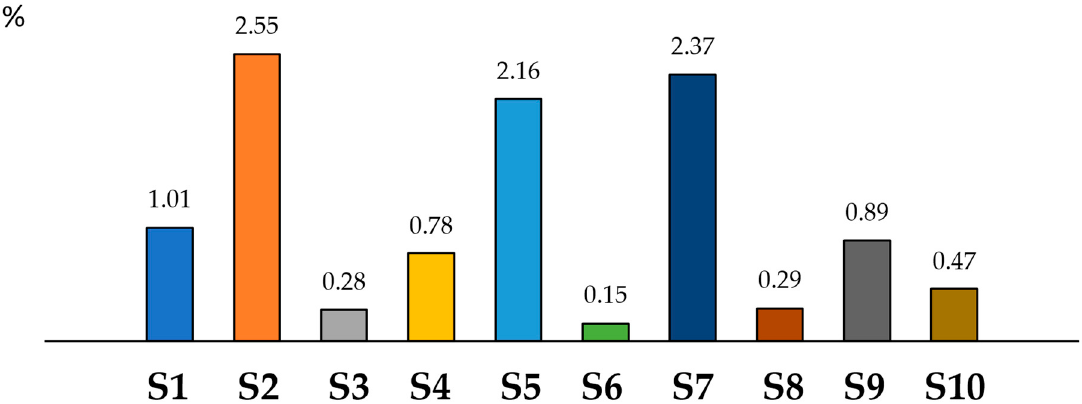
Figure 3. The percentage of recommended dietary intake of DNJ, which is covered by the dose of dietary supplements (S1–S10) suggested by manufacturers.